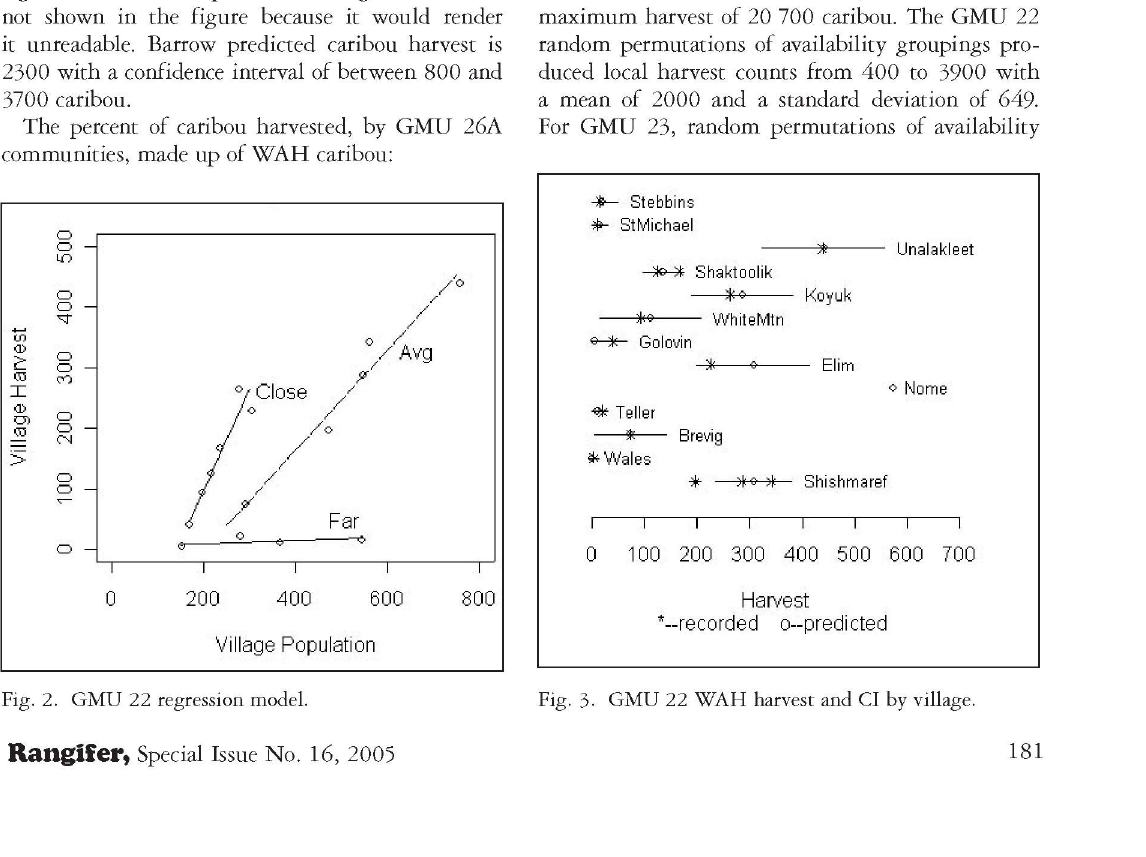
Fig. 2. GMU 22 regression model. Fig. 3. GMU 22 WAH harvest and CI by